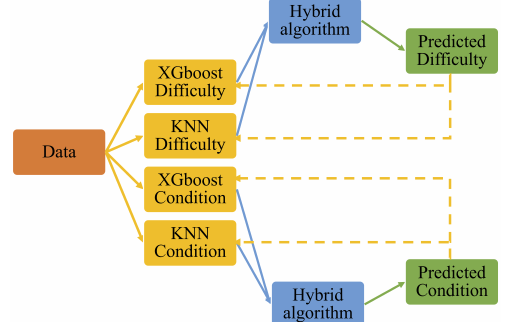
Figure 4. Graphical representation of the hybrid stacking model combining difficulty prediction and condition prediction for a medical test. The data refers to experimental plus synthetic